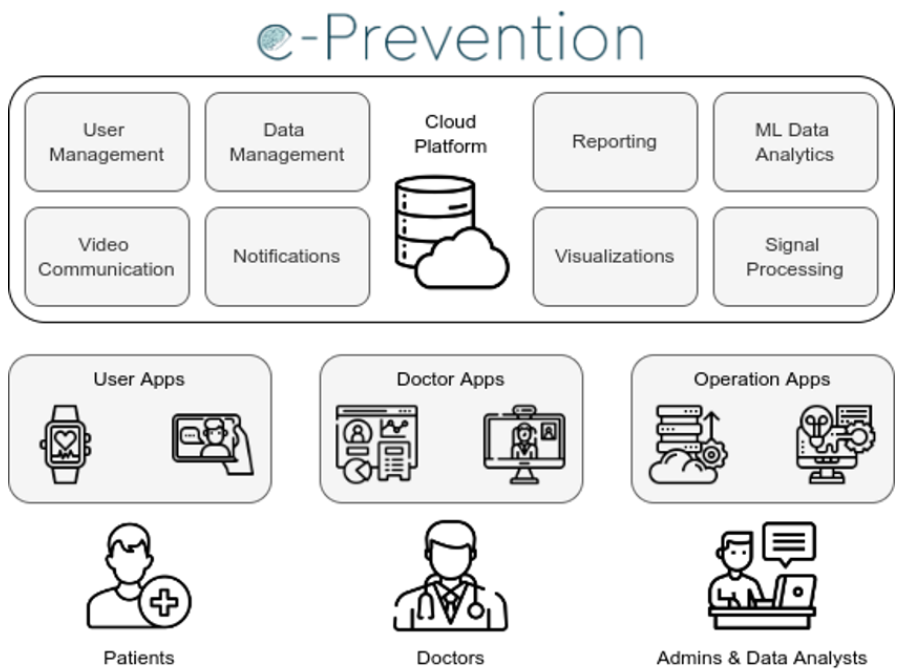
Figure 2. The overall architecture of the proposed